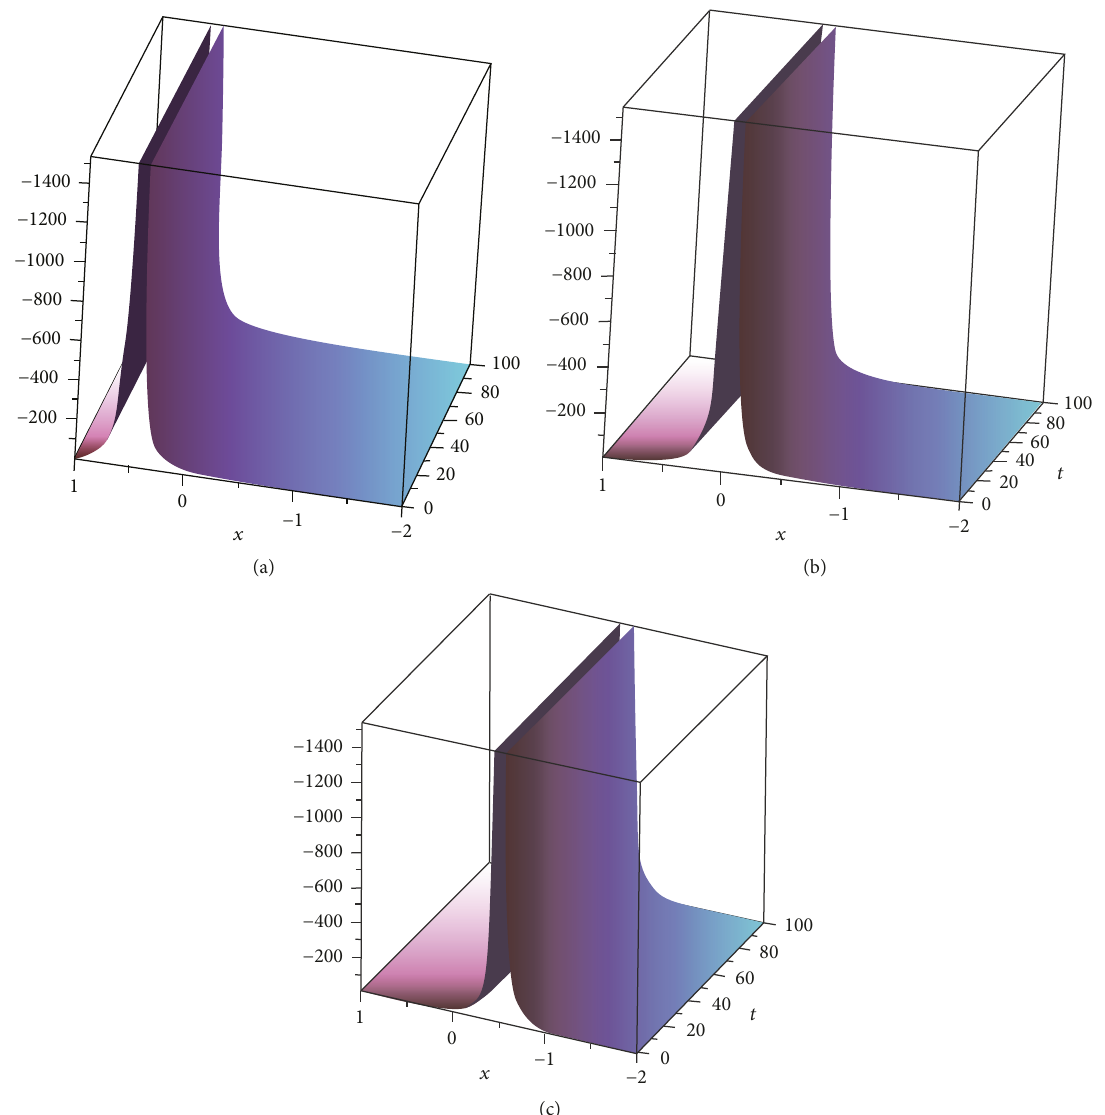
Figure 2: The solution of the Vakhnenko-Parkes equation corresponding to 𝑊 𝑟 (𝑧) , (a) 𝑧 0 = 0.5 , (b) 𝑧 0 = 0 , and (c) 𝑧 0 = −0.5 .